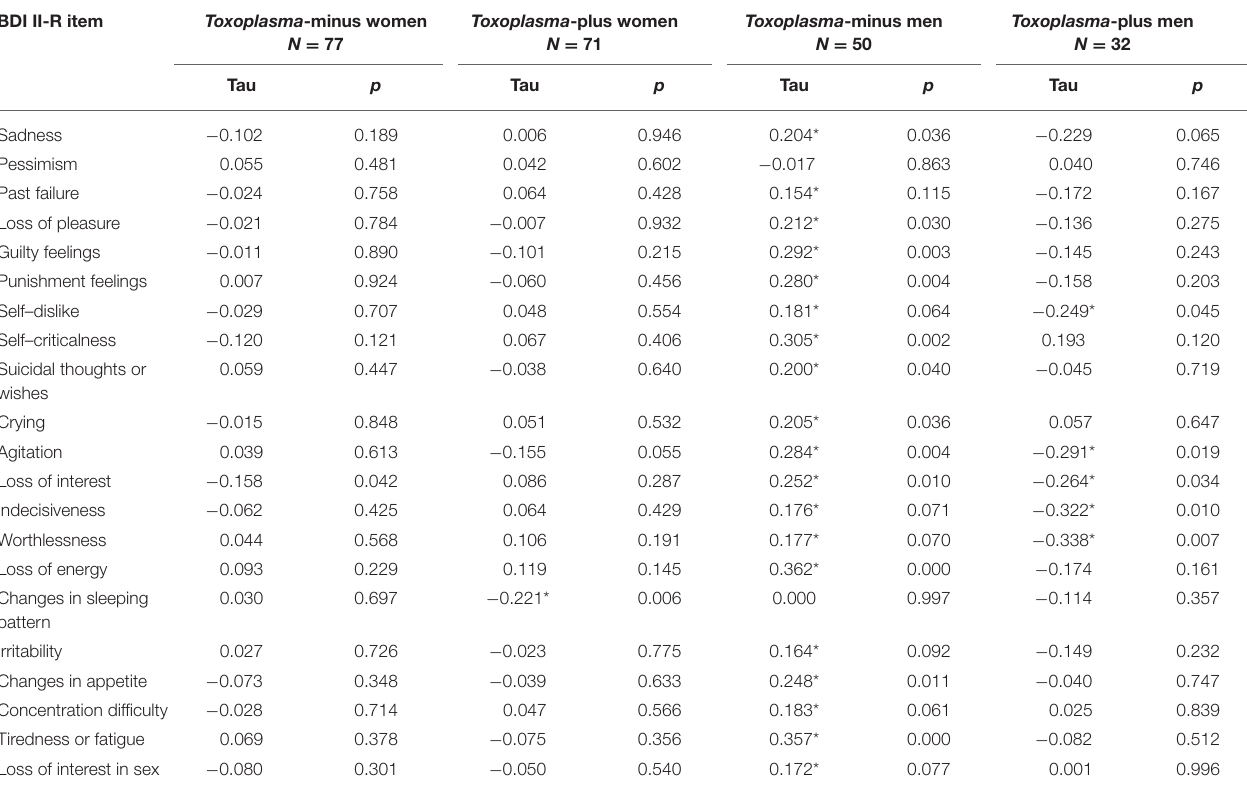
TABLE 4 | Correlation between Bartonella seropositivity and responses to BDI II questions in Toxoplasma -seronegative and Toxoplasma -seropositive subjects. BDI II-R